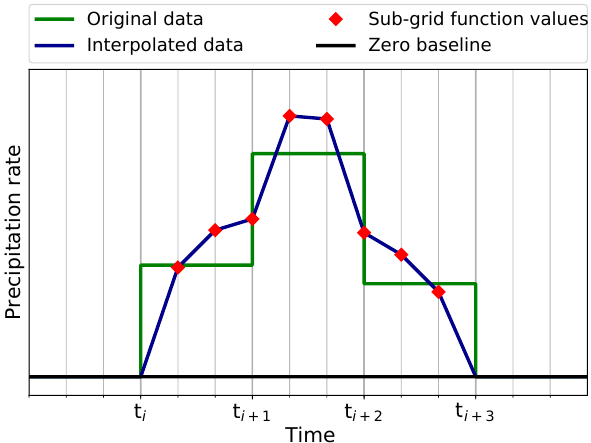
Figure 4. Illustration of a reconstruction for longer periods with positive data values, where each sub-grid function value constitutes 1 degree of